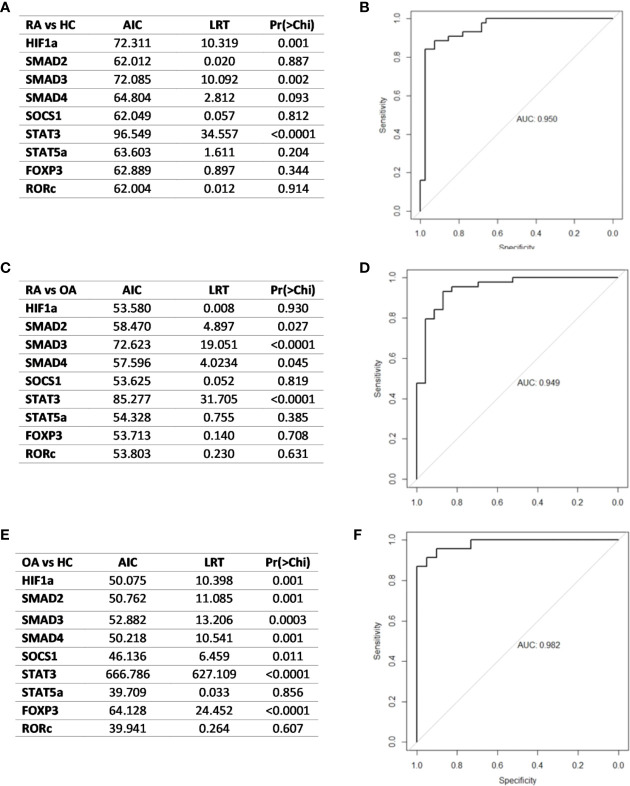

(A) Likelihood ratio test result in RA and healthy subjects (B) ROC curve and AUC value schematic representation of the logistic regression models for the combination of HIF1A, SMAD3 and STAT3-key in RA patients and healthy subjects differentiation (C). Likelihood ratio test result in RA patients and OA patients (D). Logistic regression models for the combination of in RA patients and OA patients differentiation (E). Likelihood ratio test result in OA and healthy subjects (F) logistic regression models for the combination of HIF-1A, SMAD2, SMAD3, SMAD4, SOCS1, STAT3 and FOXP3 in OA patients and healthy subjects. AIC, Akaike’s Information Criteria; LRT, Likelihood ratio test; Pr(>Chi), p-value corresponding to the Chi-square test compared to α = 0.05 level as significant.